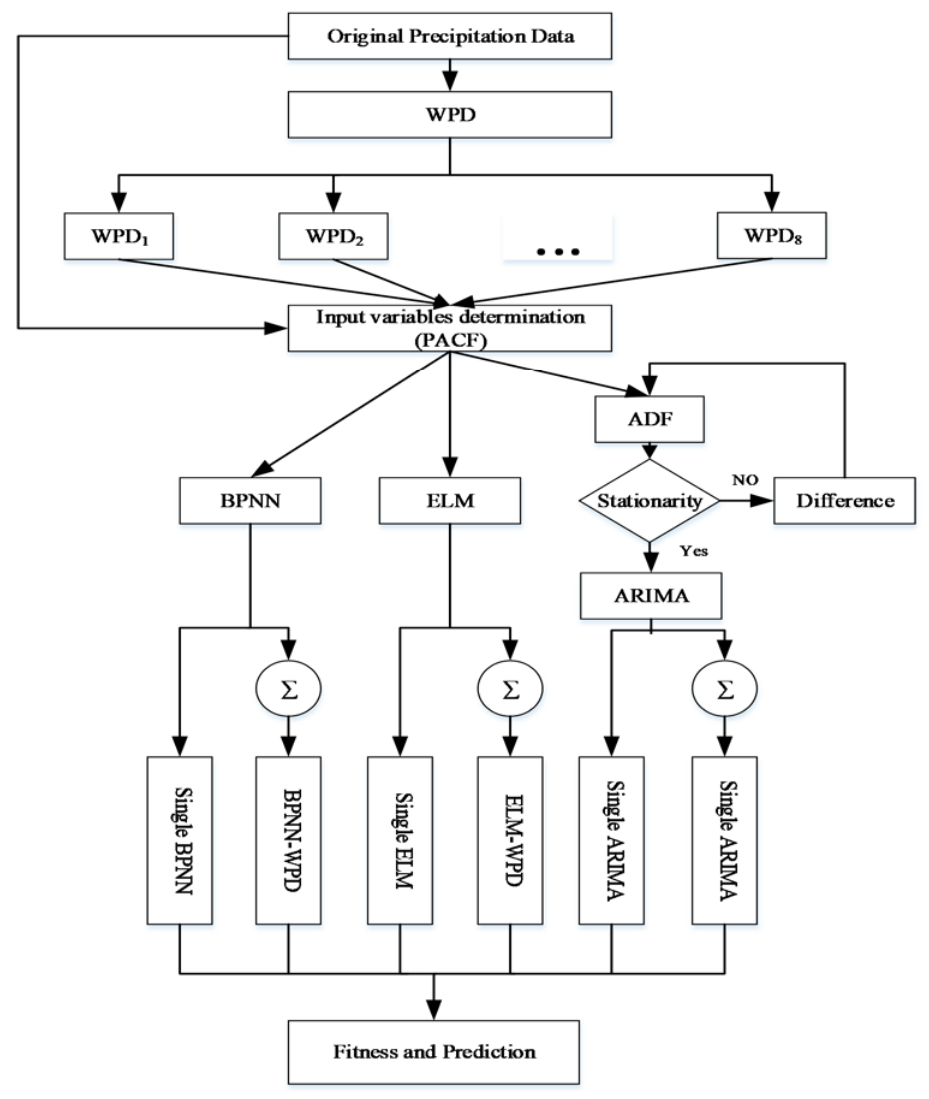
Figure 4. Framework of the proposed hybrid model.